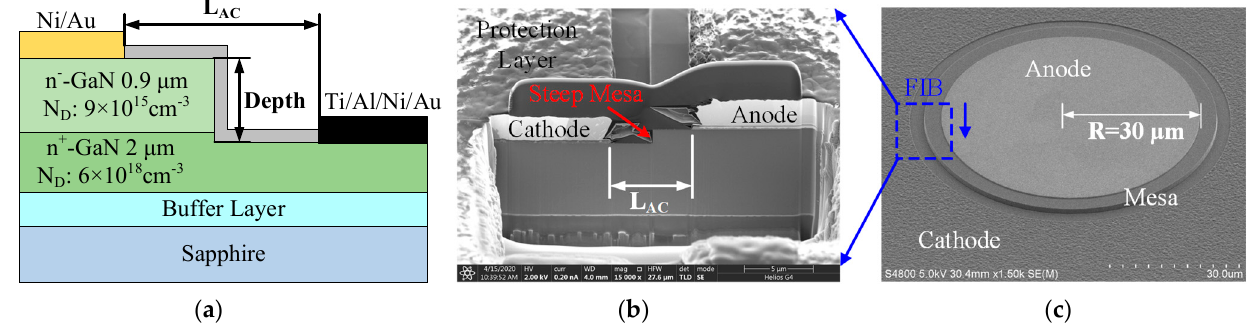
Figure 1. ( a ) Cross-section schematic; ( b ) cross-section of the SEM image; and ( c ) top view of the SEM image of the vertical GaN-on-sapphire SBD.